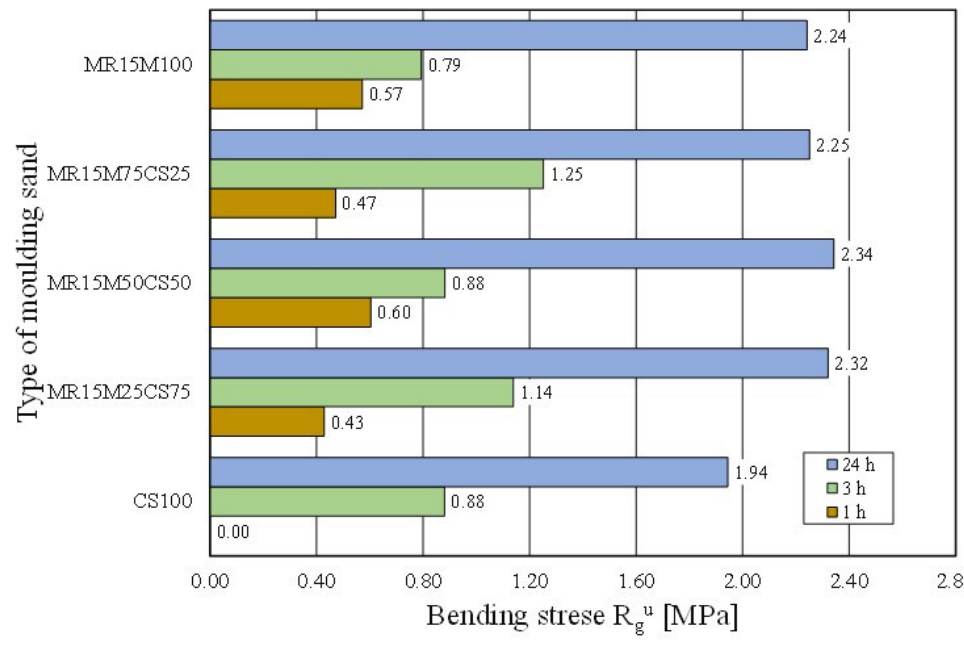
Figure 23. Bending stress R gu of tested moulding sands.